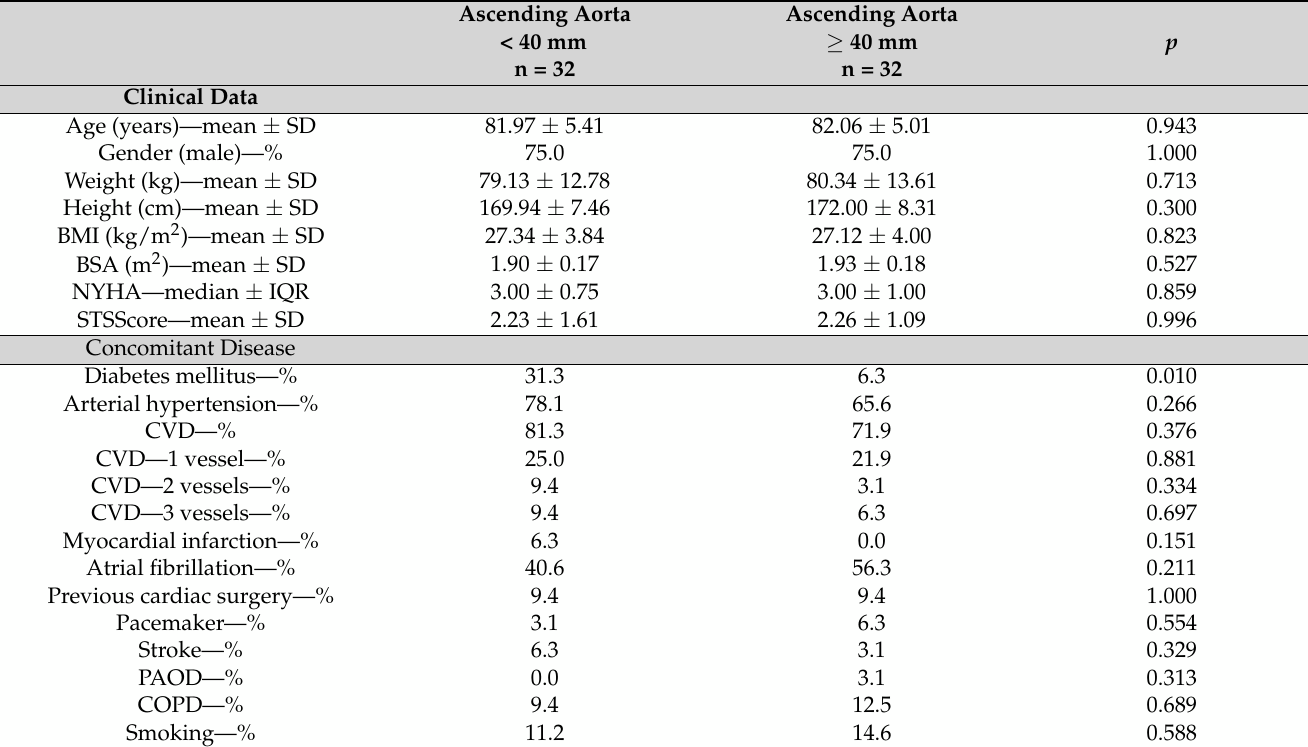
Table 1. The most important clinical, echocardiographic, radiological and laboratory criteria of the included patients in relation to an AA < 40 mm and ≥ 40